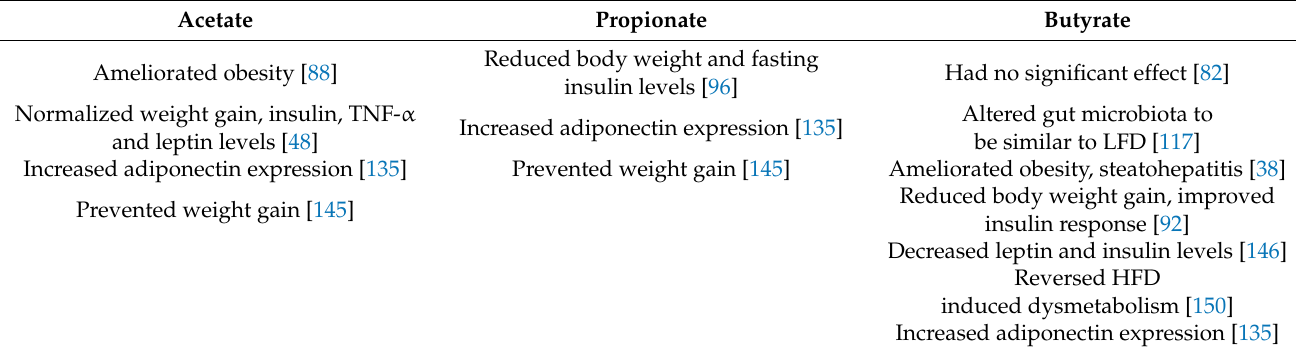
Table 2. Effects of SCFA supplementation on HFD-fed mice and